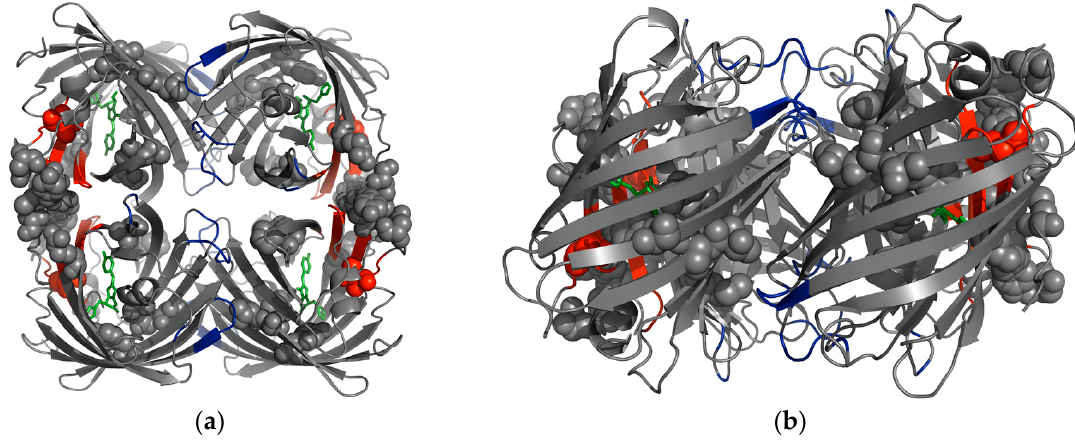
Figure 2. Tetrameric X-ray structure of the common green ancestor bearing the Q62H substitution, ALL-Q62H [13]. Residues that were mutated to generate the pcFP LEA are shown as spheres (see Table 1). Residues with large changes in percent differential flexibility index ( ∆ dfi ) values (top 15%) are shown in red (large increase in flexibility, residues 67–71, 142, 187–193, 213–215) and blue (large decrease in flexibility, residues 19–22, 50, 97–98, 125, 127–129, 165, 167). The chromophore is shown in green. ( a ) Top view; ( b ) Side view.